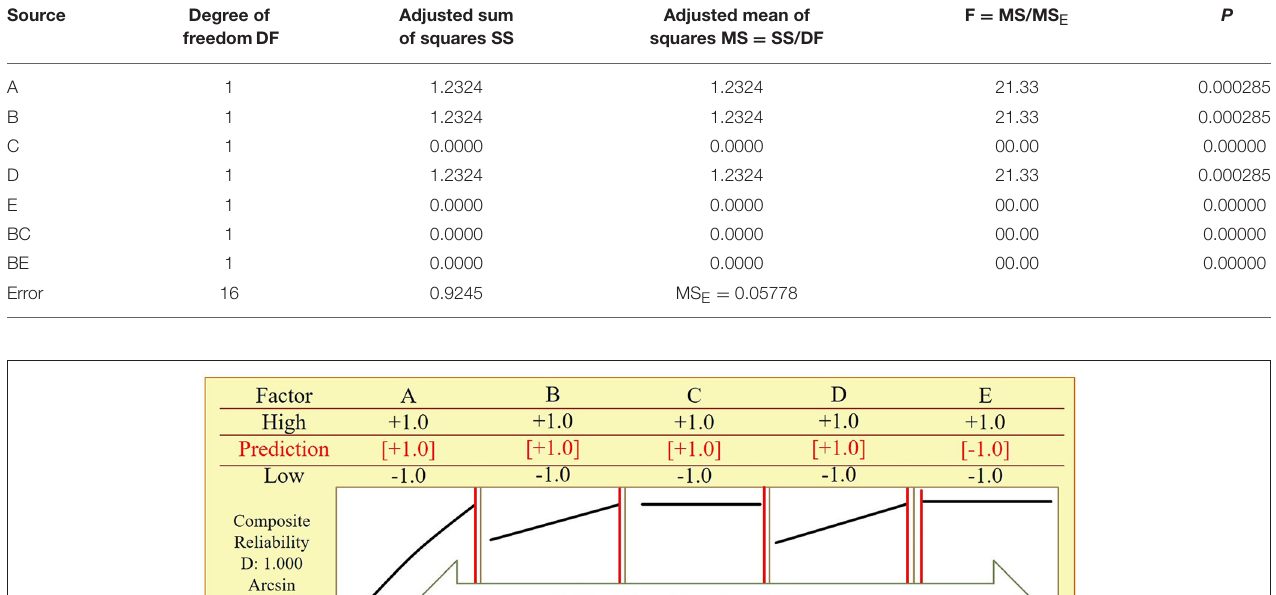
TABLE 5 | Analysis of variance for Arcsin response.